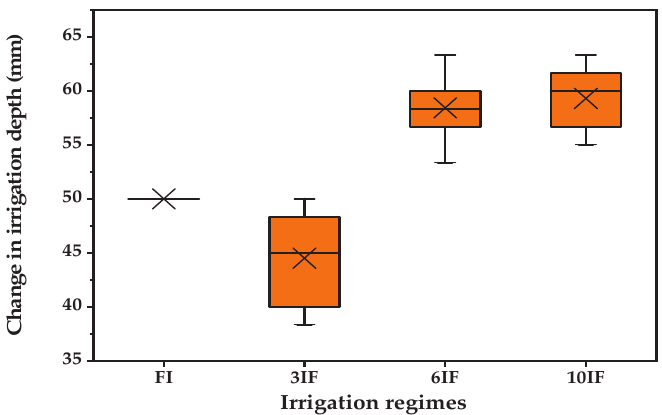
Figure 3. Change in irrigation depth during the growing seasons of 2019 and 2020 under four irrigation regimes. FI indicates flood irrigation, and 3IF, 6IF, and 10IF indicate 3-day, 6-day, and 10-day irrigation frequencies, respectively. The cross and line within the box mark the median and average, respectively; whiskers above and below the box indicate the maximum and minimum irrigation depth during the growing seasons,